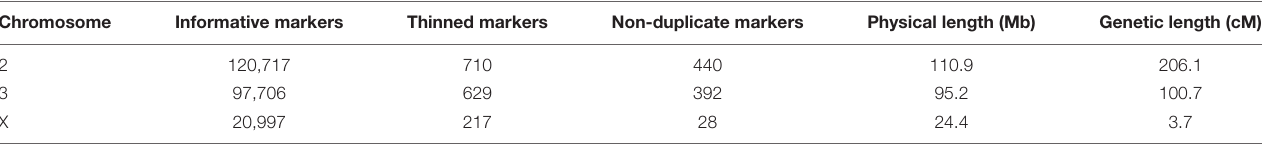
TABLE 1 | The number of ancestry informative, thinned, and non-duplicate markers genotyped in hybrids, and the physical and map distances of each chromosome in the cross.